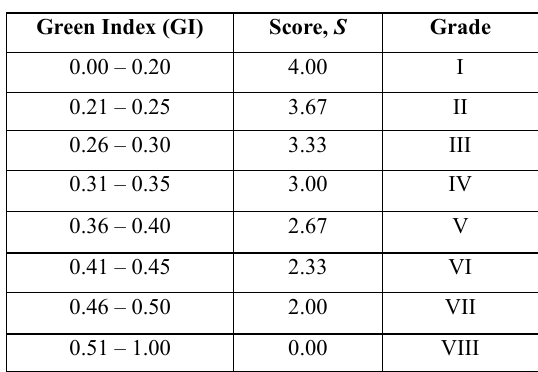
Table 1. Weighted-grading approach for Green Performance Index